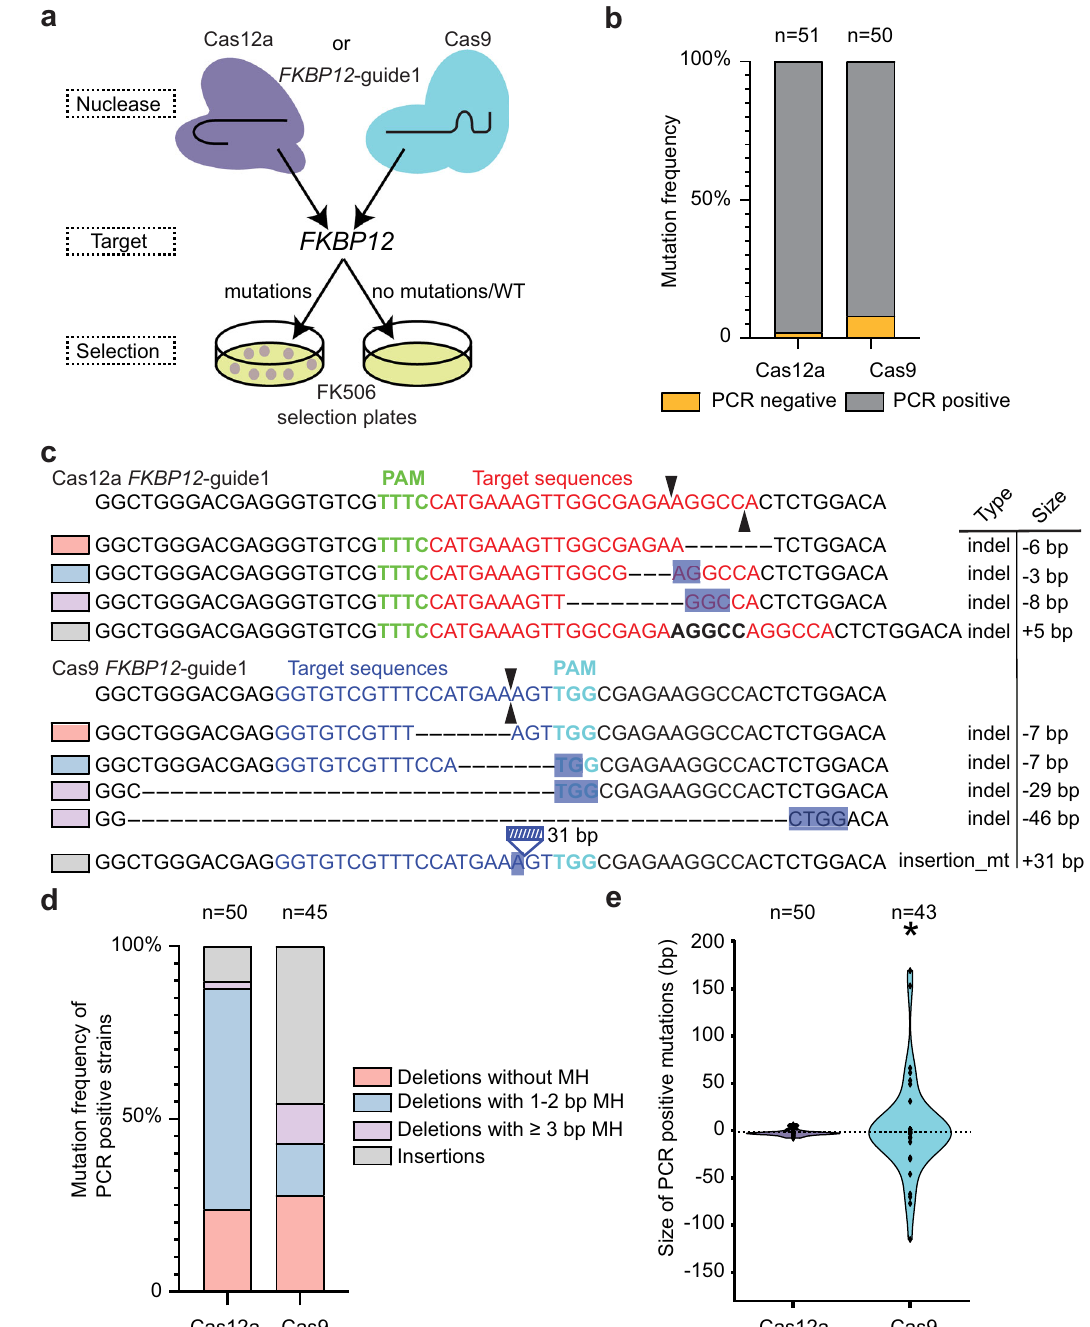
Fig.7|Distinctmutationalpro fi lescausedbyCas12aandCas9intheabsenceof a DNA donor. a Schematic illustration of a new editing scheme targeting FKBP12 locus by using either Cas12a or Cas9 FKBP12 -guide1 RNP with FK506 direct selec- tion. b The mutation frequency of PCR negative and PCR positive outcome in Cas12a or Cas9 edited FK506 R transformants. The number of independent